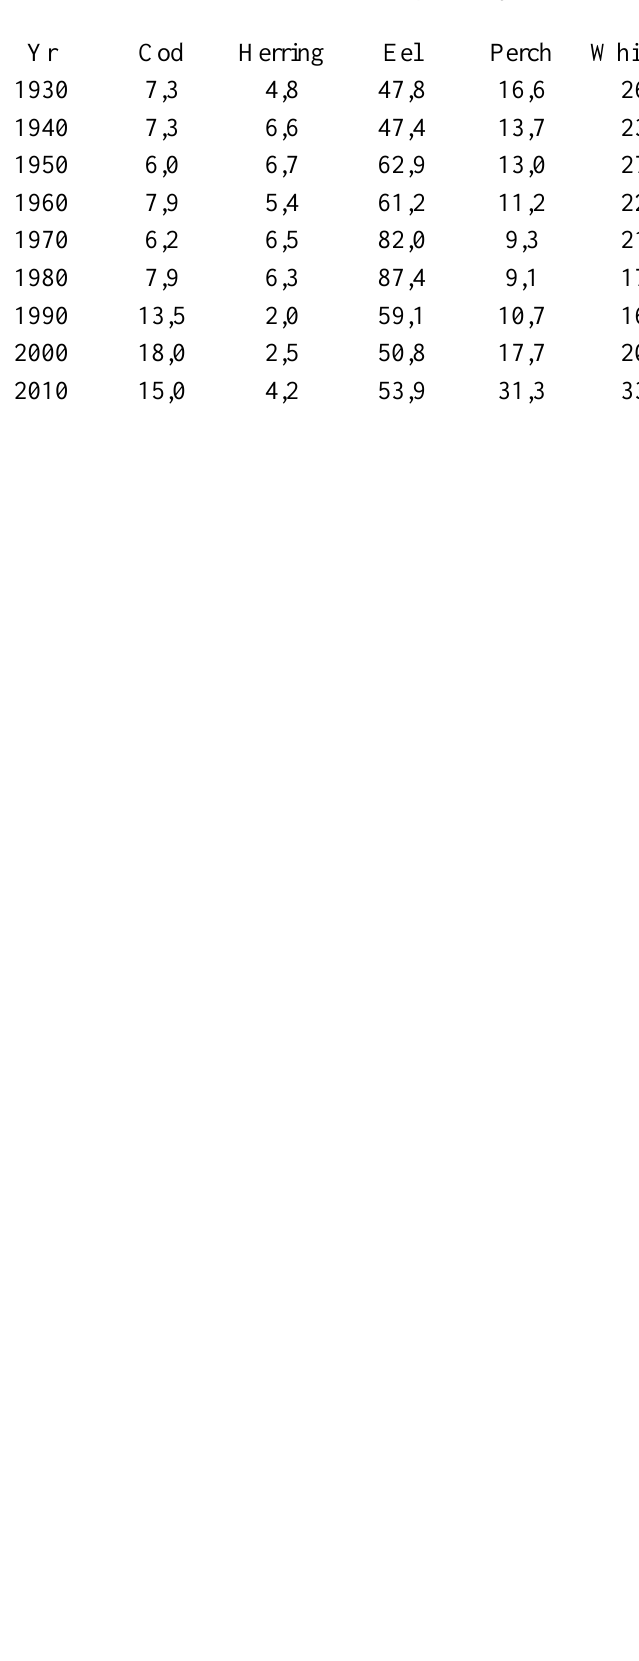
Table A2.1. Prices for the eel and four other common species the fishers target at nine different points in time. The unit is Swedish Krona per kilo fish and all values are reported in fixed values (i.e. were compensated for inflation using the Swedish Consumer Price Index (CPI)). Source: Swedish official statistic compiled by Jonas